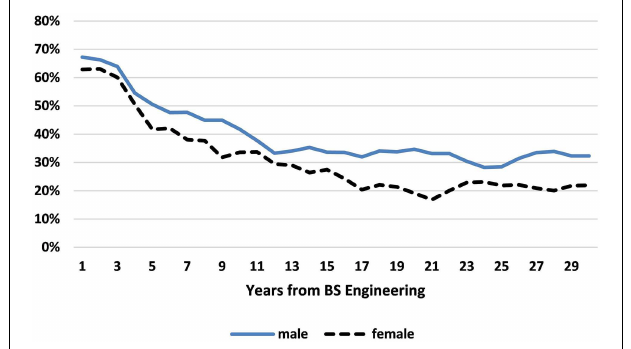
FIGURE 2 | Percent of female and male Bachelors of Engineering (BSEs) remaining in engineering, by years from BSE (3-year moving averages). Data Source: NSF SESTAT Survey 2010.